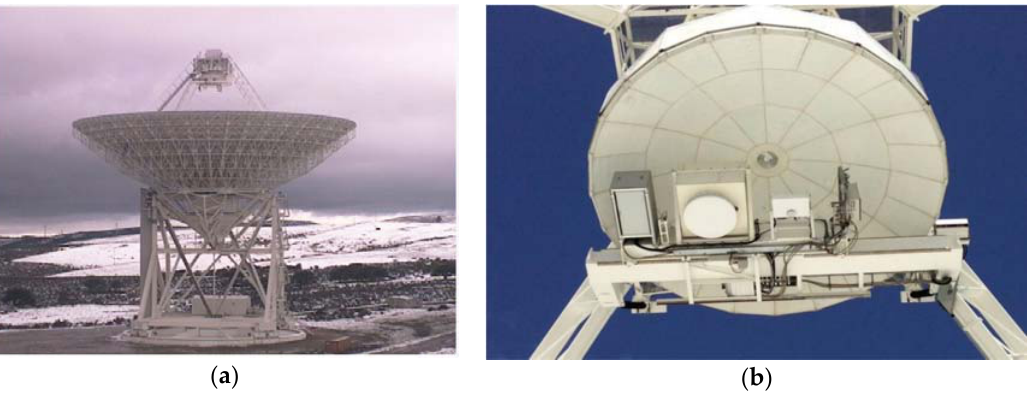
Figure 1. ( a ) The Sardinia Radio Telescope; ( b ) The L ‐ P cryogenic receiver installed on the SRT primary focal position.